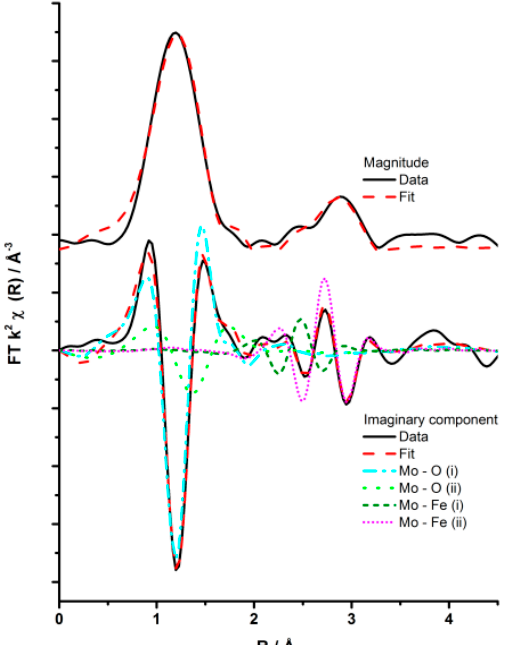
Figure 12. Magnitude and imaginary component of the k 2 ‐ weighted Fourier transform (non phase ‐ corrected) for the EXAFS data of the 1ML MoO x /Fe 2 O 3 catalyst calcined to 500 °C/24 h. Associated scattering paths are included for the imaginary component. Image adapted from C. Brookes et al. , J. Phys. Chem. C , 2014, 118 (45), pp. 26155–26161 [7]. Table 2. EXAFS fitting parameters for the 1ML MoO x /Fe 2 O 3 catalyst calcined to 500 °C Fitting parameters: S 02 = 0.82 as deduced by MoO 3 standard: Fit range 2.6 < k < 9.7, 1 < R < 3.5; # of independent points = 11. Where N = Co ‐ ordination number, R = Bond distance/Å of the Absorber ‐ Scatterer, 2 σ 2 =